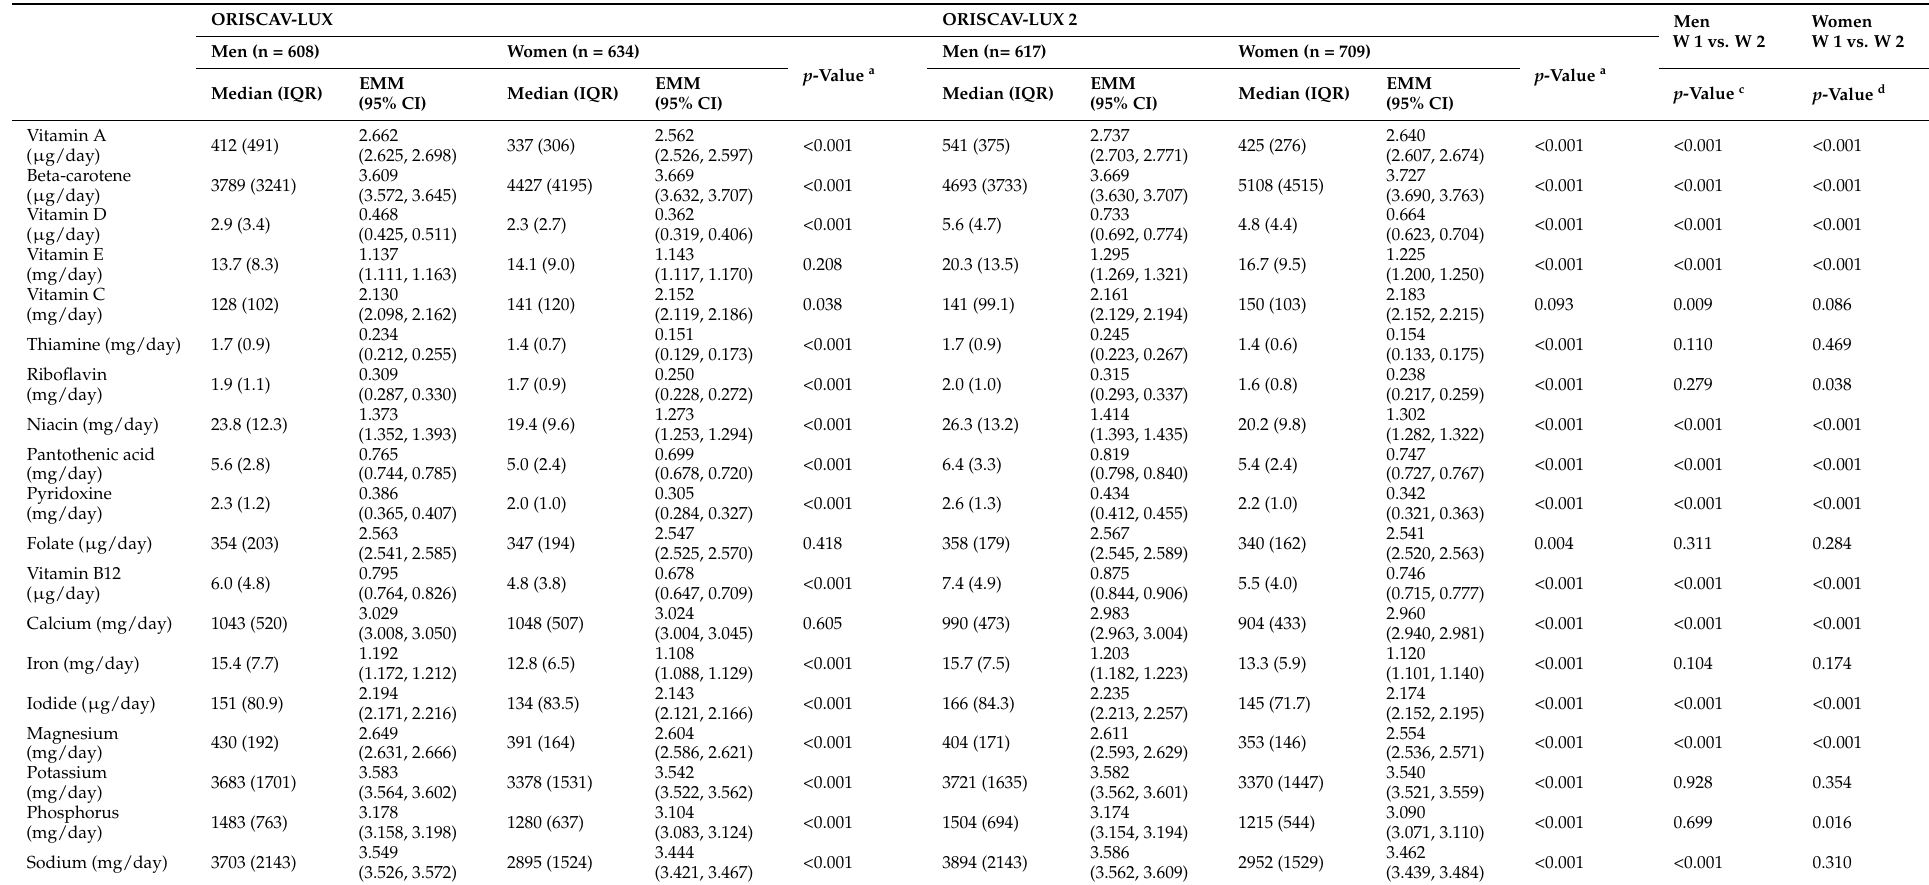
Table 6. Within- and between-group comparisons* of micronutrients based on gender groups ( p -values are based on linear mixed model) e .